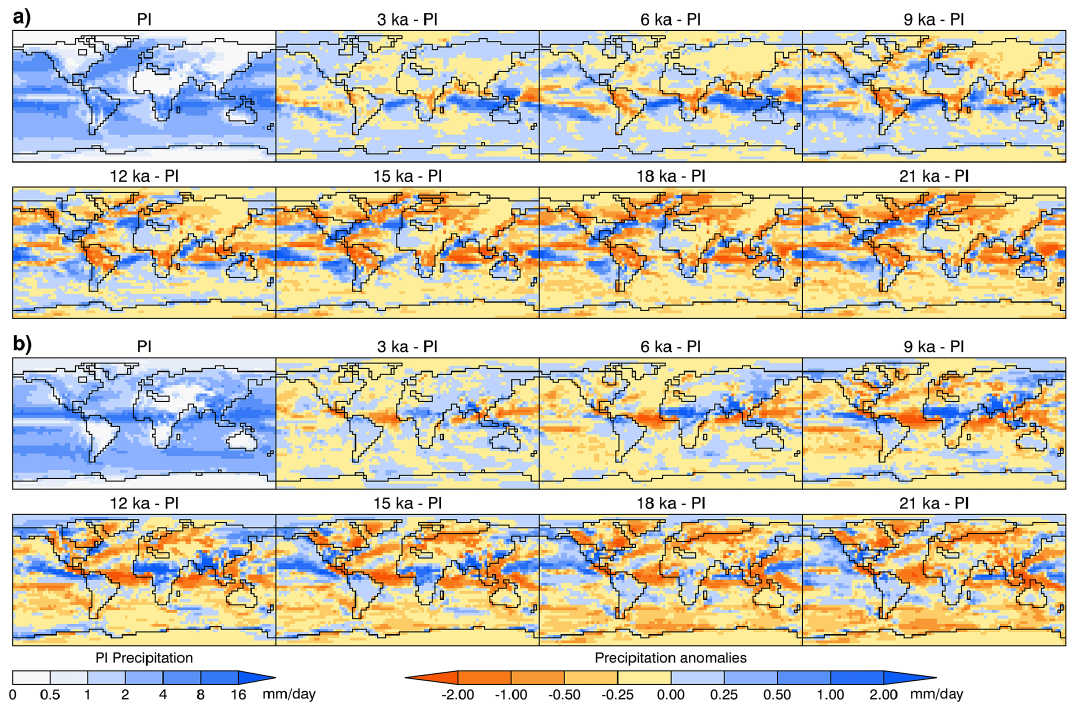
Figure 8. Simulated seasonal average precipitation anomalies relative to PI. (a) December, January, and February and (b) June, July, and August.